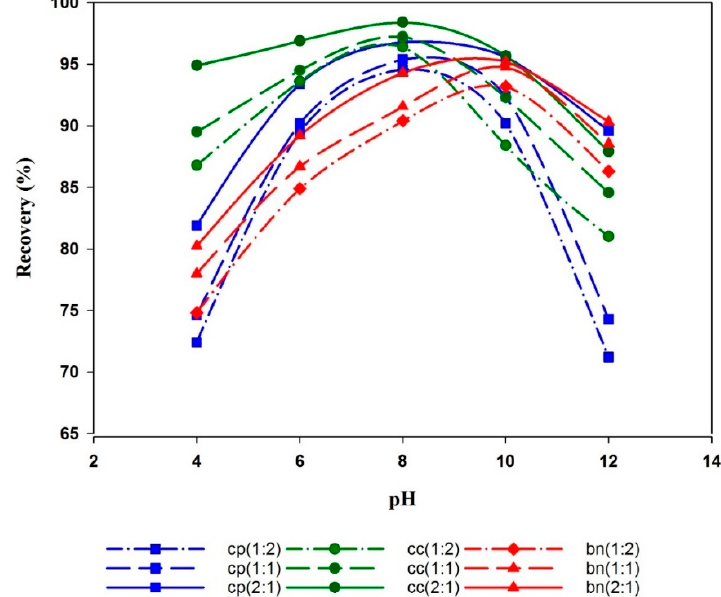
Figure 5. Hallimond flotation recovery of copper sulphides in presence of collector blend (SIBX:BBT) as a function of pH at collector concentration 3 × 10 − 5 M. cp-chalcopyrite, cc-chalcocite, bn-bornite.